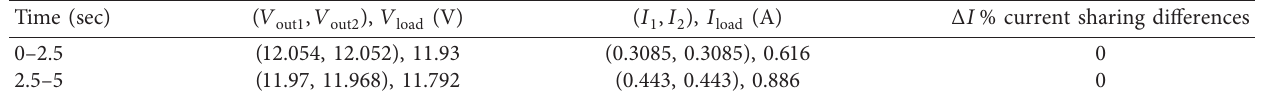
Table 4: Simulation results with the proposed algorithm.